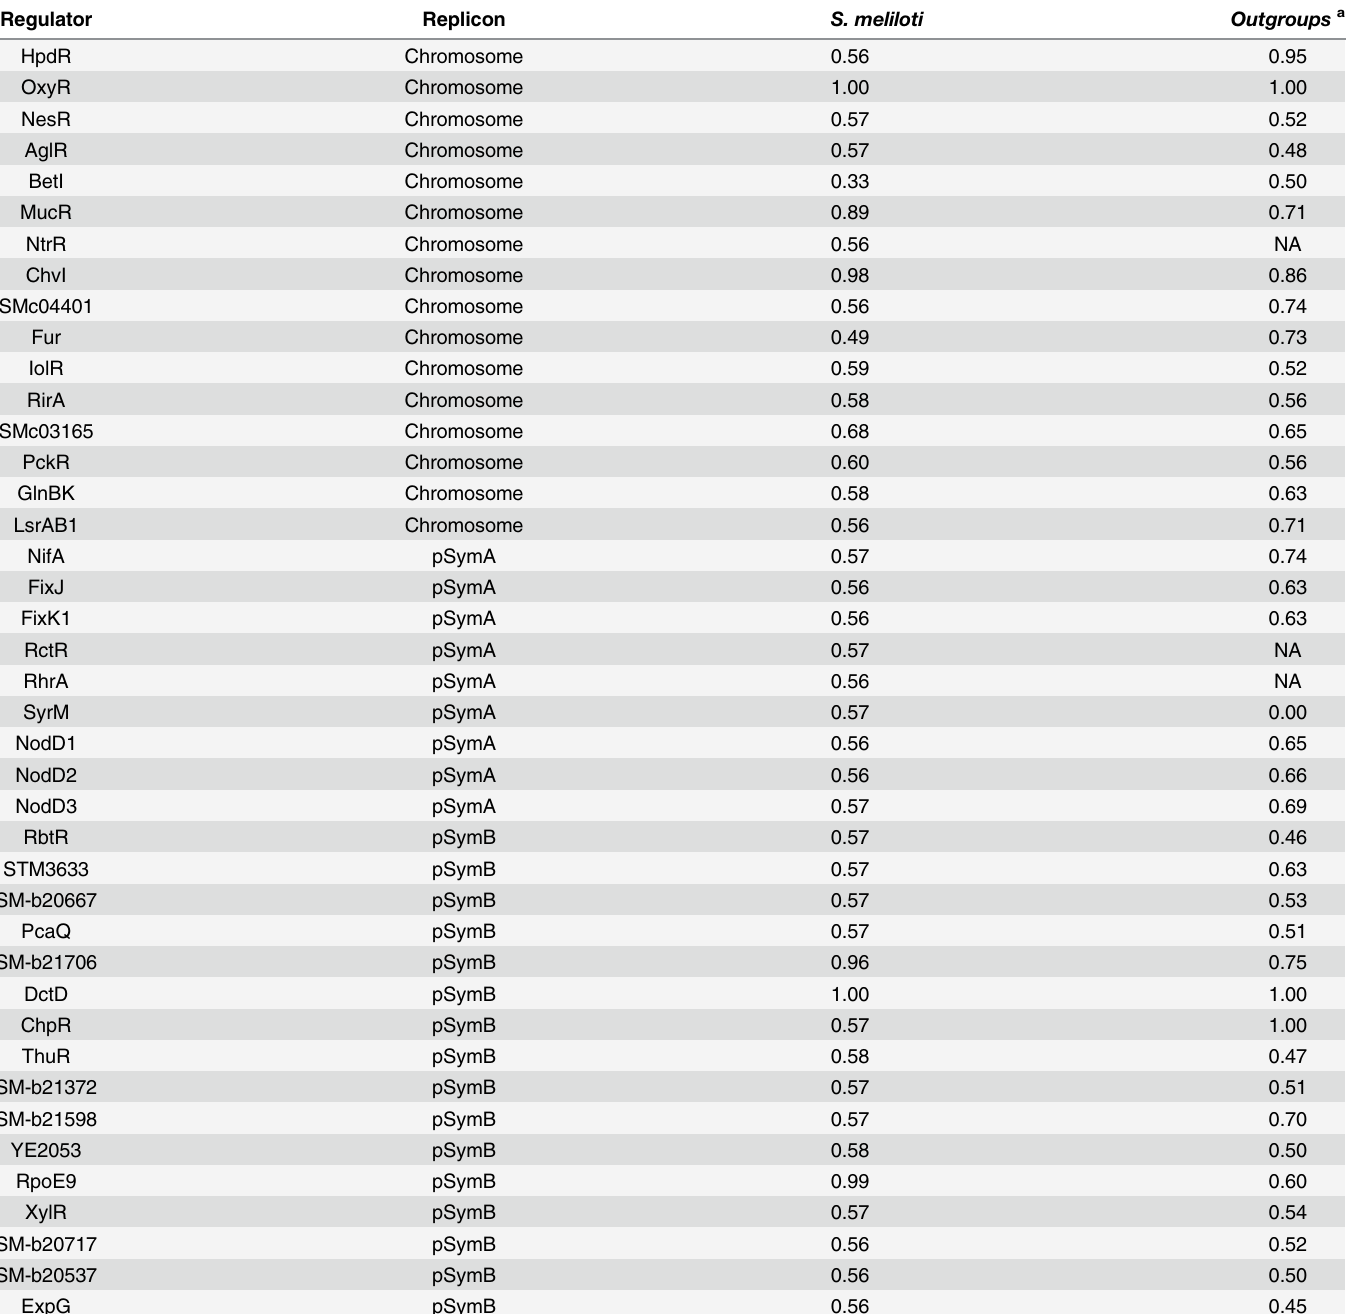
Table 2. Regulon